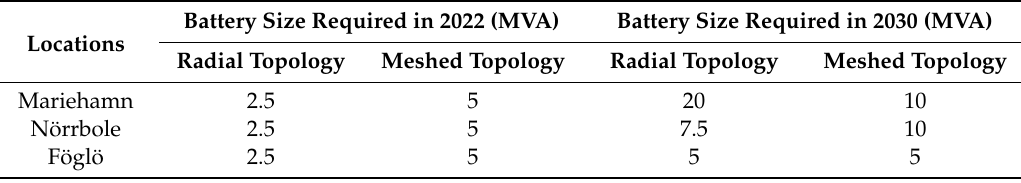
Table 3. Sizing and Locations of BESS for 2022 and